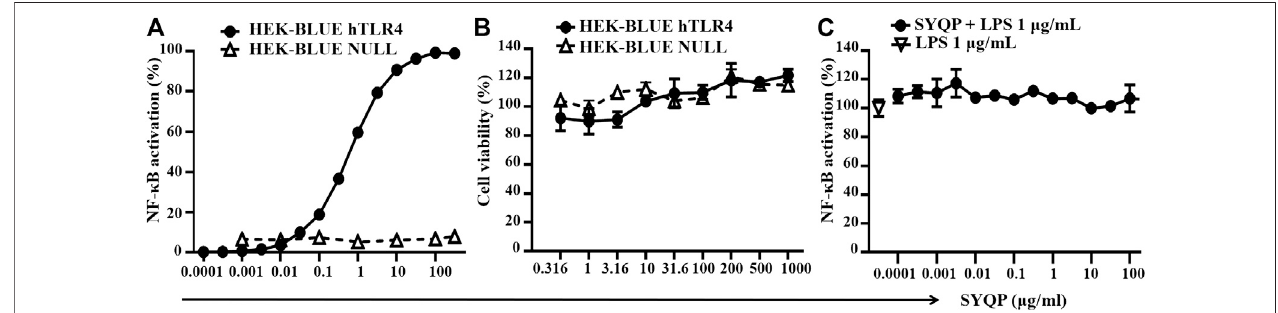
FIGURE 1 | SYQP stimulated human TLR4 in HEK-BLUE hTLR4 cells. (A) SYQP could activate NF- κ B in HEK-BLUE hTLR4 but not HEK-BLUE NULL cells. (B) SYQP showed no cytotoxicity. Cells were treated with SYQP for 24 h, and cell viability was evaluated by MTS assay. (C) SYQP pretreatment could not inhibit LPS- inducedNF- κ BactivationinHEK-BLUEhTLR4cells.CellculturesupernatantsweremixedwithQUANTI-BLUEsubstratetotestthelevelofSEAP,whichrepresentedthe activity of NF- κ B in the HEK-BLUE reporter cells. All of the data were normalized to the 1 μ g/ml LPS-treated group, which represented the maximum response of the cells. All of the results are presented as the mean ± SD ( n (cid:2)